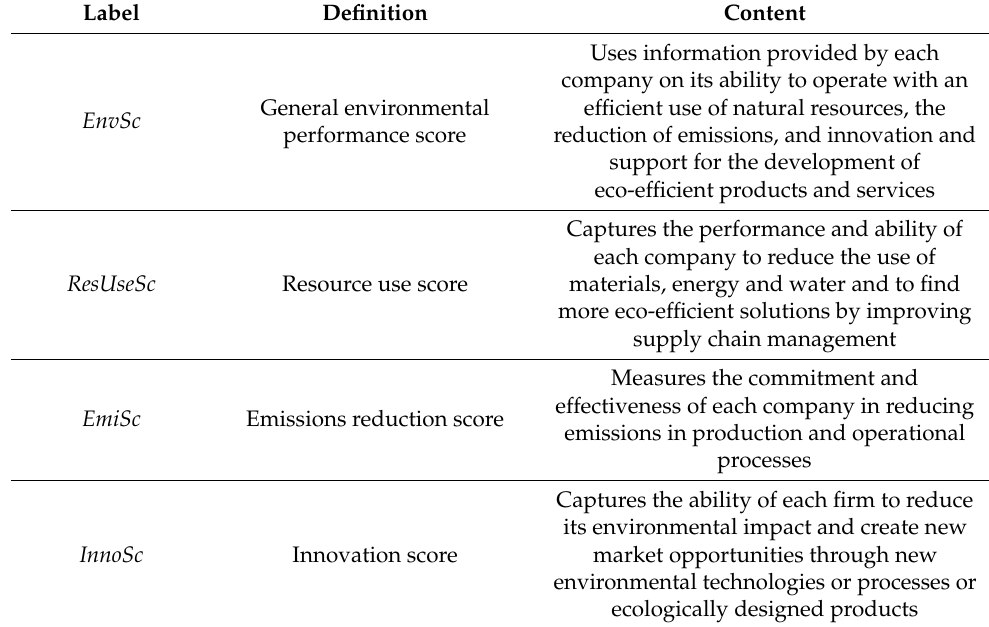
Table 3. Environmental performance variables.